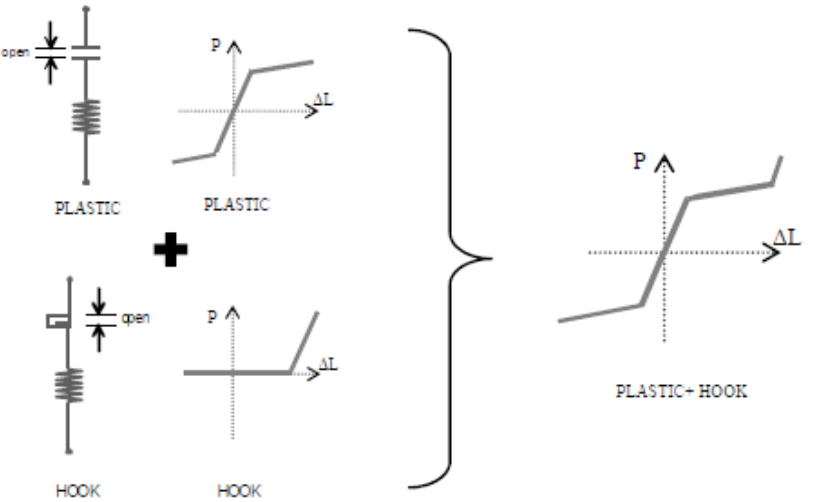
Figure 5. Installation of two CAR1 dampers in X-shaped steel diagonal braces.